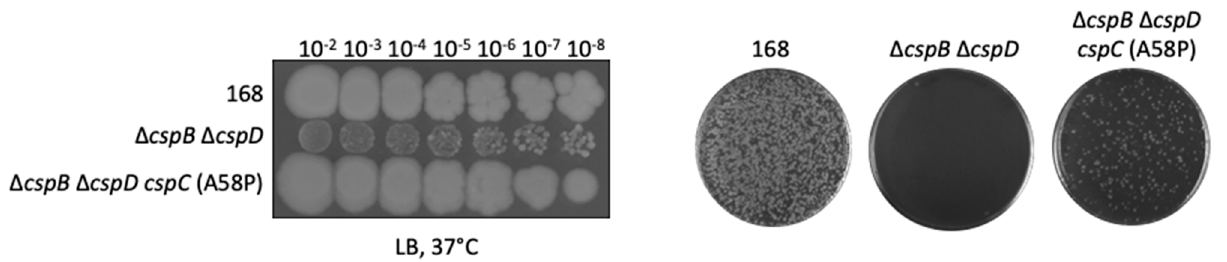
Figure 5. The cspC (A58P) variant restores growth and genetic competence in the ∆ cspB ∆ cspD background. The left panel shows the strains B. subtilis wild type 168, GP1971 ( ∆ cspB ∆ cspD ), and GP3275 ( ∆ cspB ∆ cspD cspC (A58P) that were cultivated on LB-agar at 37 ◦ C for 36 h. The right panel shows the transformants obtained after transformation an equal number of competent cells with 200 ng of chrom. DNA. Data are representative of three biological replicates.